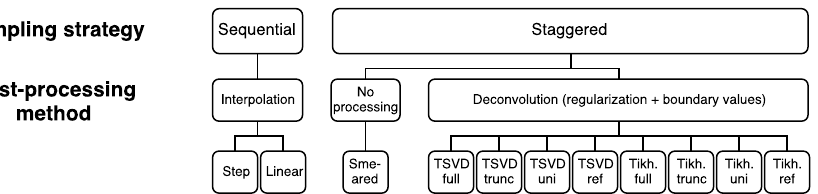
Figure 2. Sampling strategies and post-processing methods for increasing time resolution. Each method is explained in detail in the main text in Sect. 3. Step: step function, linear: linear function, TSVD: TSVD regularization, Tikh.: Tikhonov regularization, full: no loss of the boundary values corresponding to partial measurement samples, trunc: loss of all boundary values corresponding to partial measurement samples, uni: truncated signal uniformly padded to the length of the full, smeared signal, ref: truncated signal reflectively padded to the length of the full, smeared